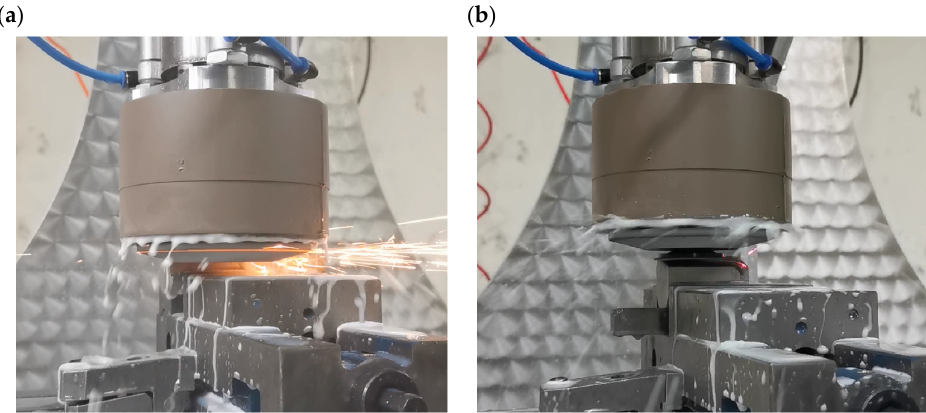
Figure 9. View of the machining zone during the grinding process using a dual-tool grinding head: ( a ) coarse grinding using a ceramic grinding wheel; ( b ) finish grinding using a prone grinding wheel.